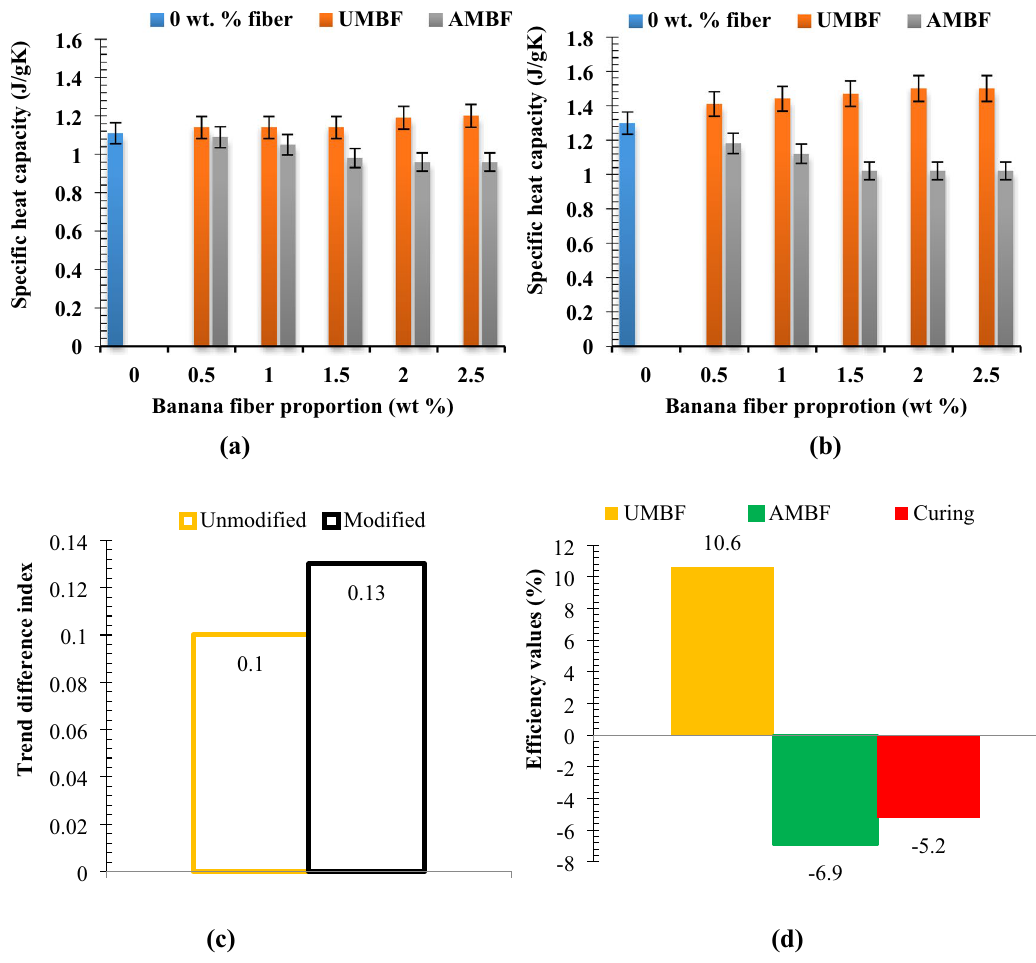
Figure 10. Relation between fiber proportion of unmodified and modified fiber on specific heat capacity at curing days of ( a ) 28 days and ( b ) 56 days with ( c ) experimental trend analysis and ( d ) property evaluation of experimental